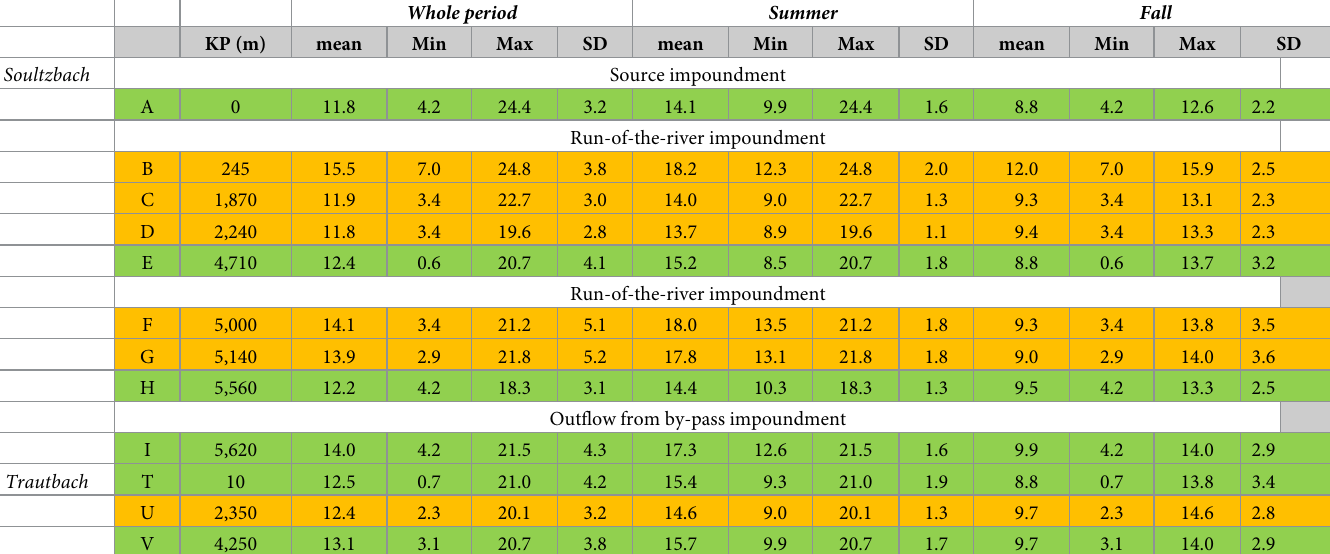
Summer: from June 11 th to September 20 th . Fall: from September 21 st to December 11 th . Green background indicates forest landscape, while orange background indicates open grassland landscape. The kilometric point (KP) indicates distance from the stream source. Dates when minimal and maximal temperatures were reached are indicated in S1A